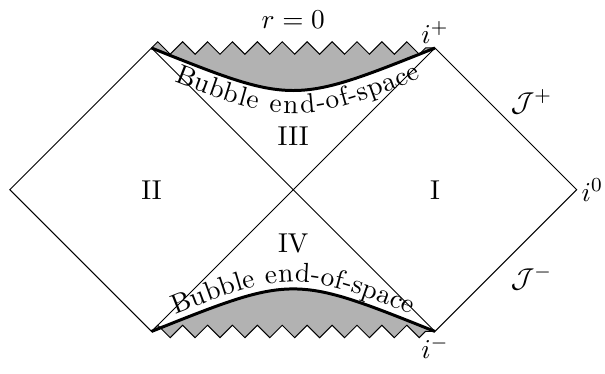
Figure 4 . Penrose diagram of the black